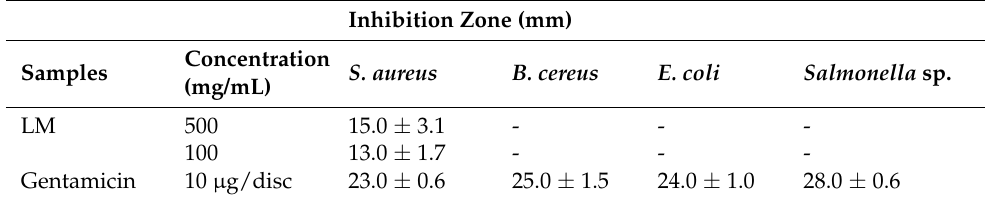
Table 4. Inhibition zone produced by LM against test